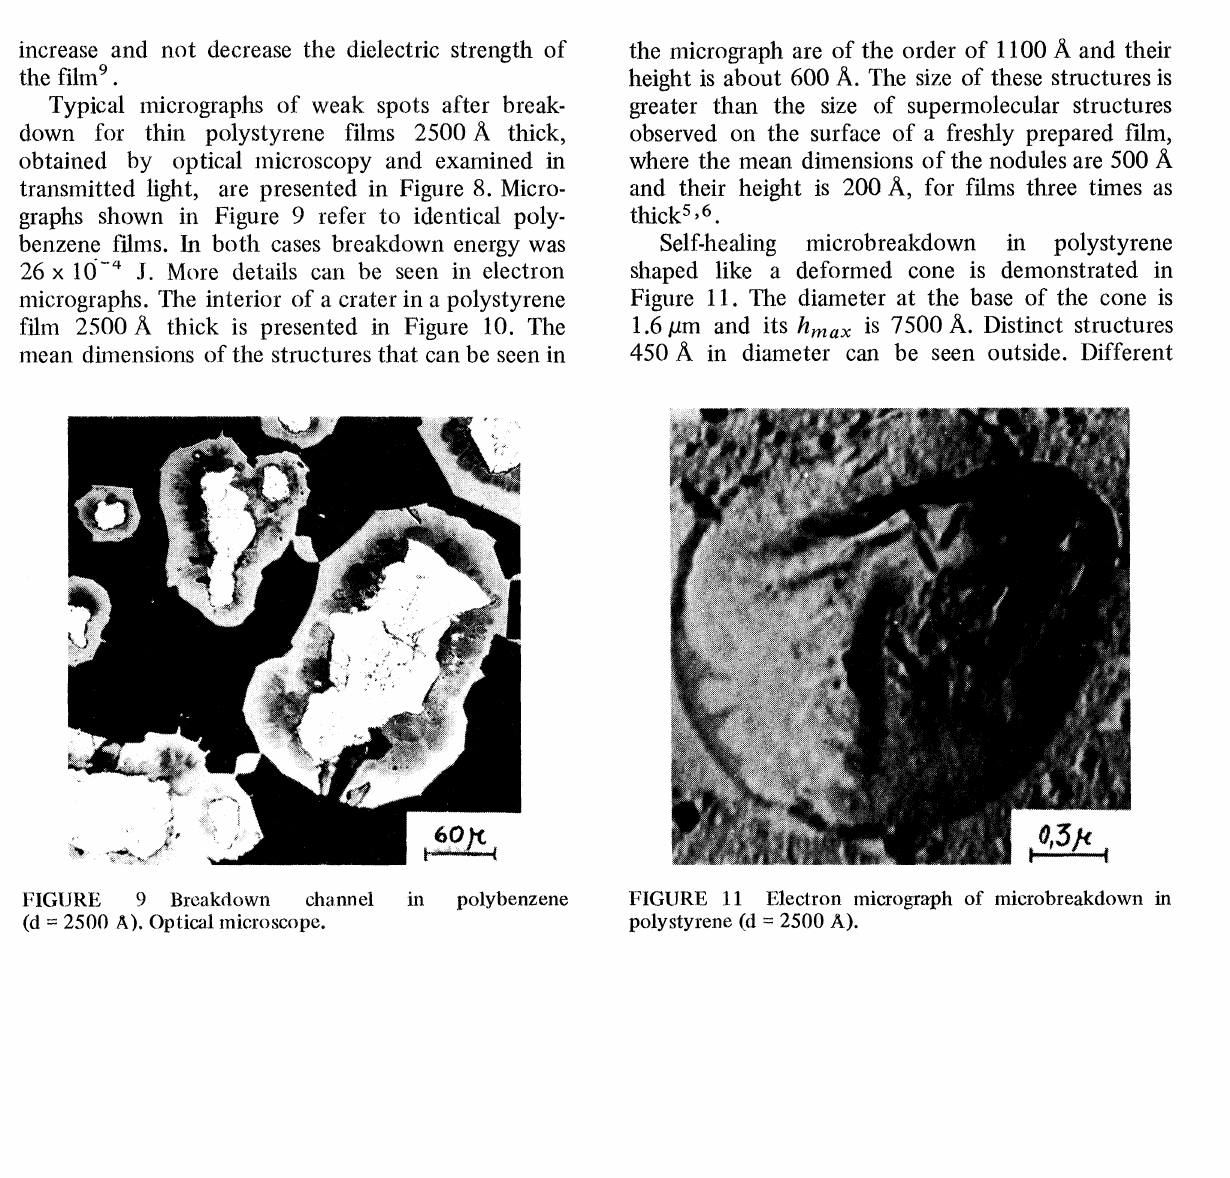
FIGURE 10 Electron micrograph of the interior of the channel in polystyrene (d 2500 A).